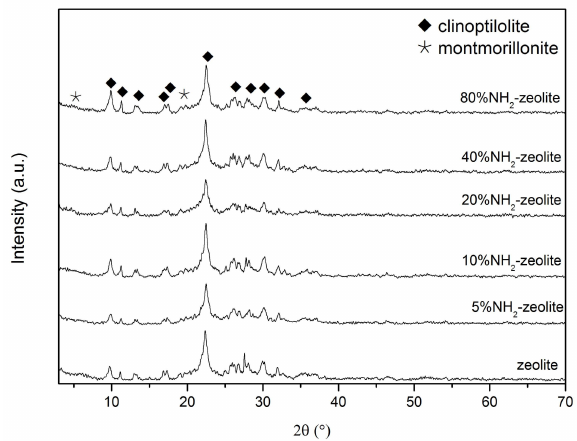
Figure 2. X-ray diffraction (XRD) patterns of zeolite and amino functionalized zeolite samples.